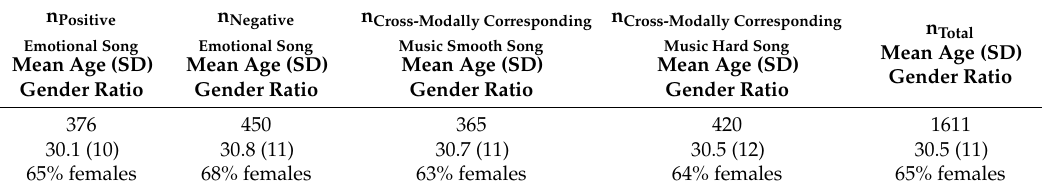
Table 2. Sample sizes (n), average age with corresponding standard deviation (SD) in years, as well as gender ratio, for each between-participants experimental